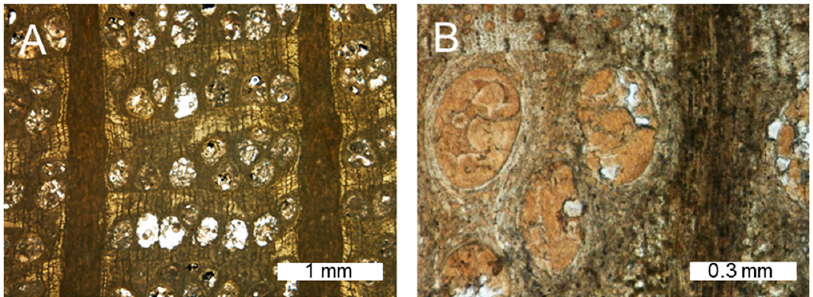
Figure 6. Petrographic thin sections of the 2014 specimen, transverse plane. ( A , B ) show anatomical detail matching Schuster’s Table III, Figures 1 and 2, respectively [7].